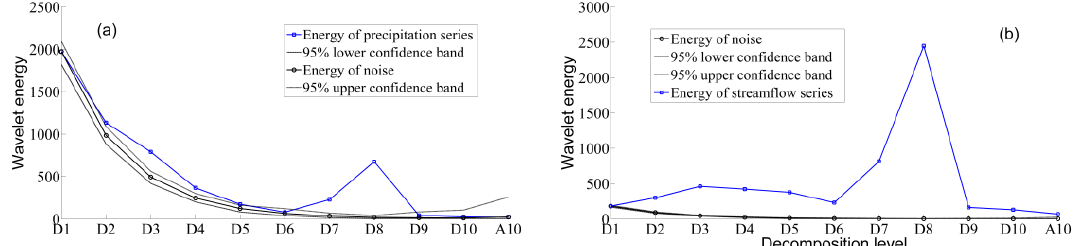
Figure 4. Energy functions of the precipitation ( a ); and streamflow( b ) series and the reference energy function with 95% confidence interval.